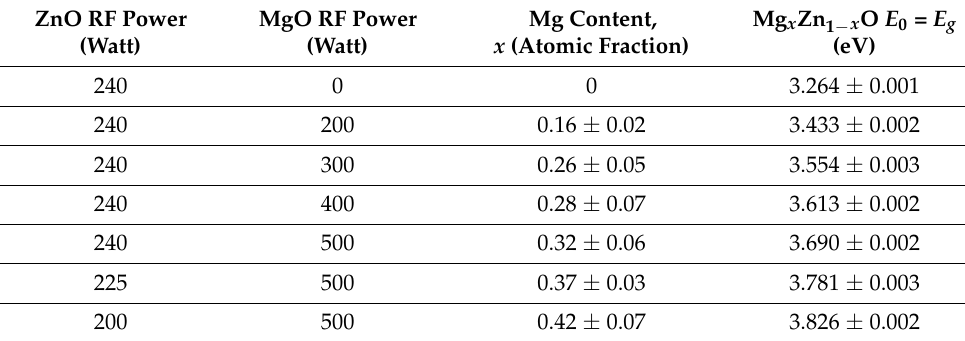
Table 1. The RF magnetron power settings for sputtering of MgO and ZnO targets, the Mg molar fraction x for each sample as determined from energy dispersive X-ray spectroscopy measurements, and the resulting MZO bandgap from NIR-UV spectroscopic ellipsometry measurements. For the sample with the third highest x , the power applied to the MgO target has reached its limit, and for higher x , the power applied to the ZnO target is